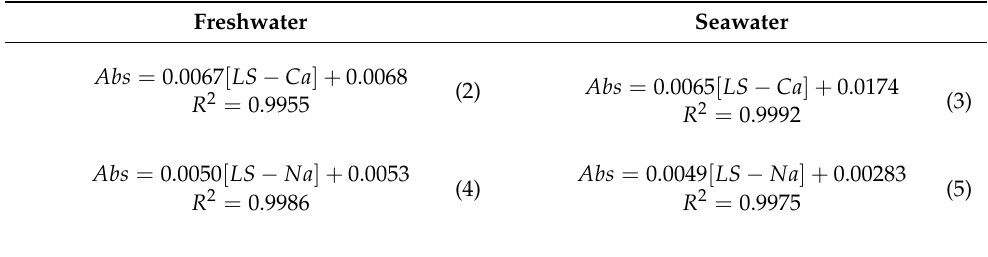
Table 4. Equations of the calibration curves to measure the lignosulphonate concentration in seawater and freshwater.